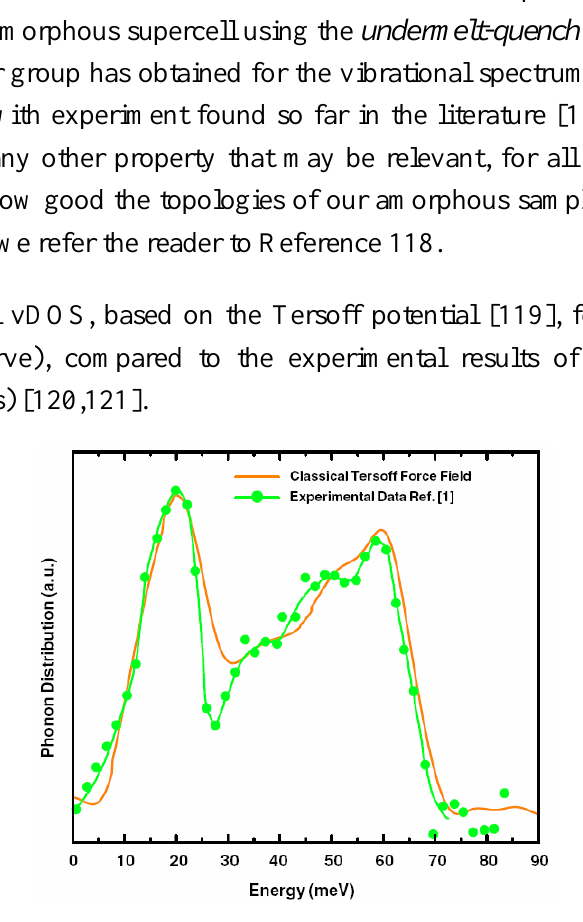
Figure 42. Quantum vDOS for our 216-atom a -Si network (black curve), compared to the experimental results of Kamitakahara et al. (green curve and dots)